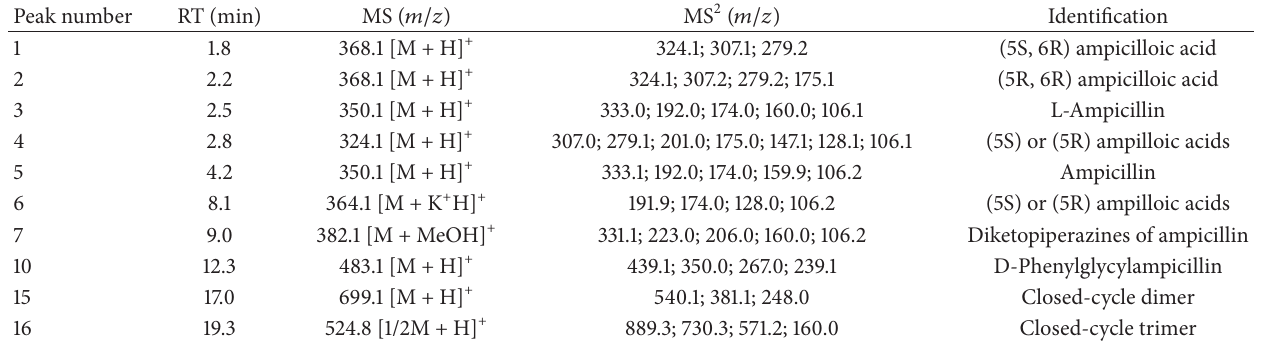
Table 2: Results of identification of the known related substances in ampicillin